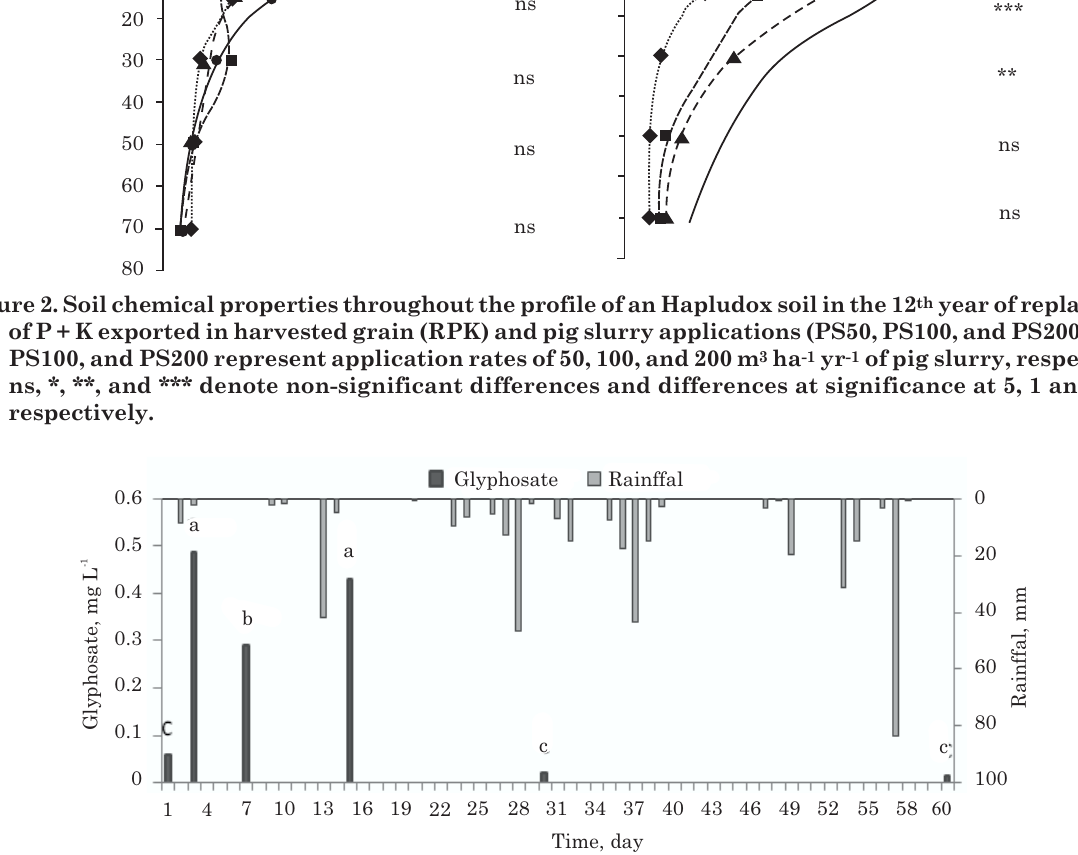
Figure 3. Concentrations of glyphosate and rainfall during the sampling period. Bars identified by different letters are different among themselves (Tukey,